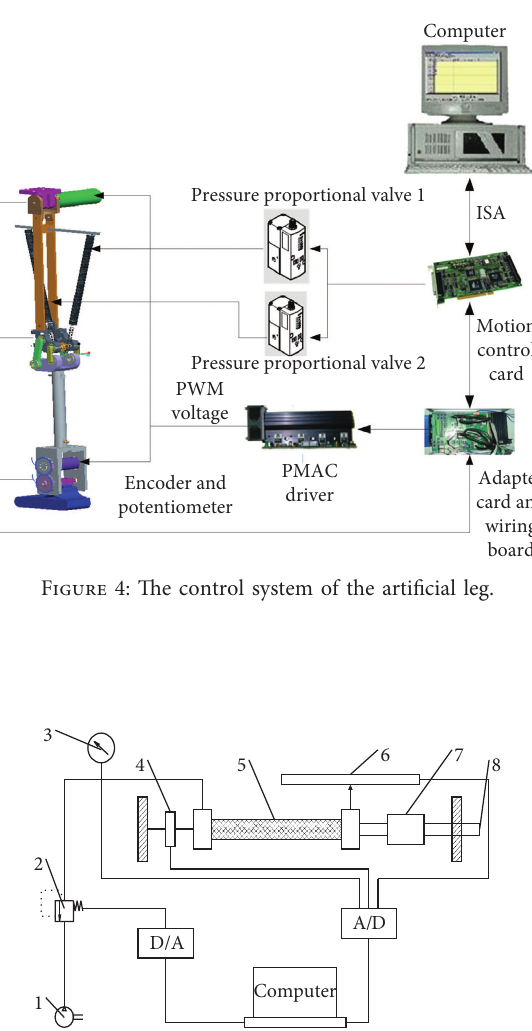
Figure 5: The experimental program of static characteristics of PAM. 1, air compressor; 2, pressure proportional valve; 3, pressure sensor; 4, tension sensor; 5, pneumatic artificial muscle; 6, dis- placement sensor; 7, stepper motor; 8, ball